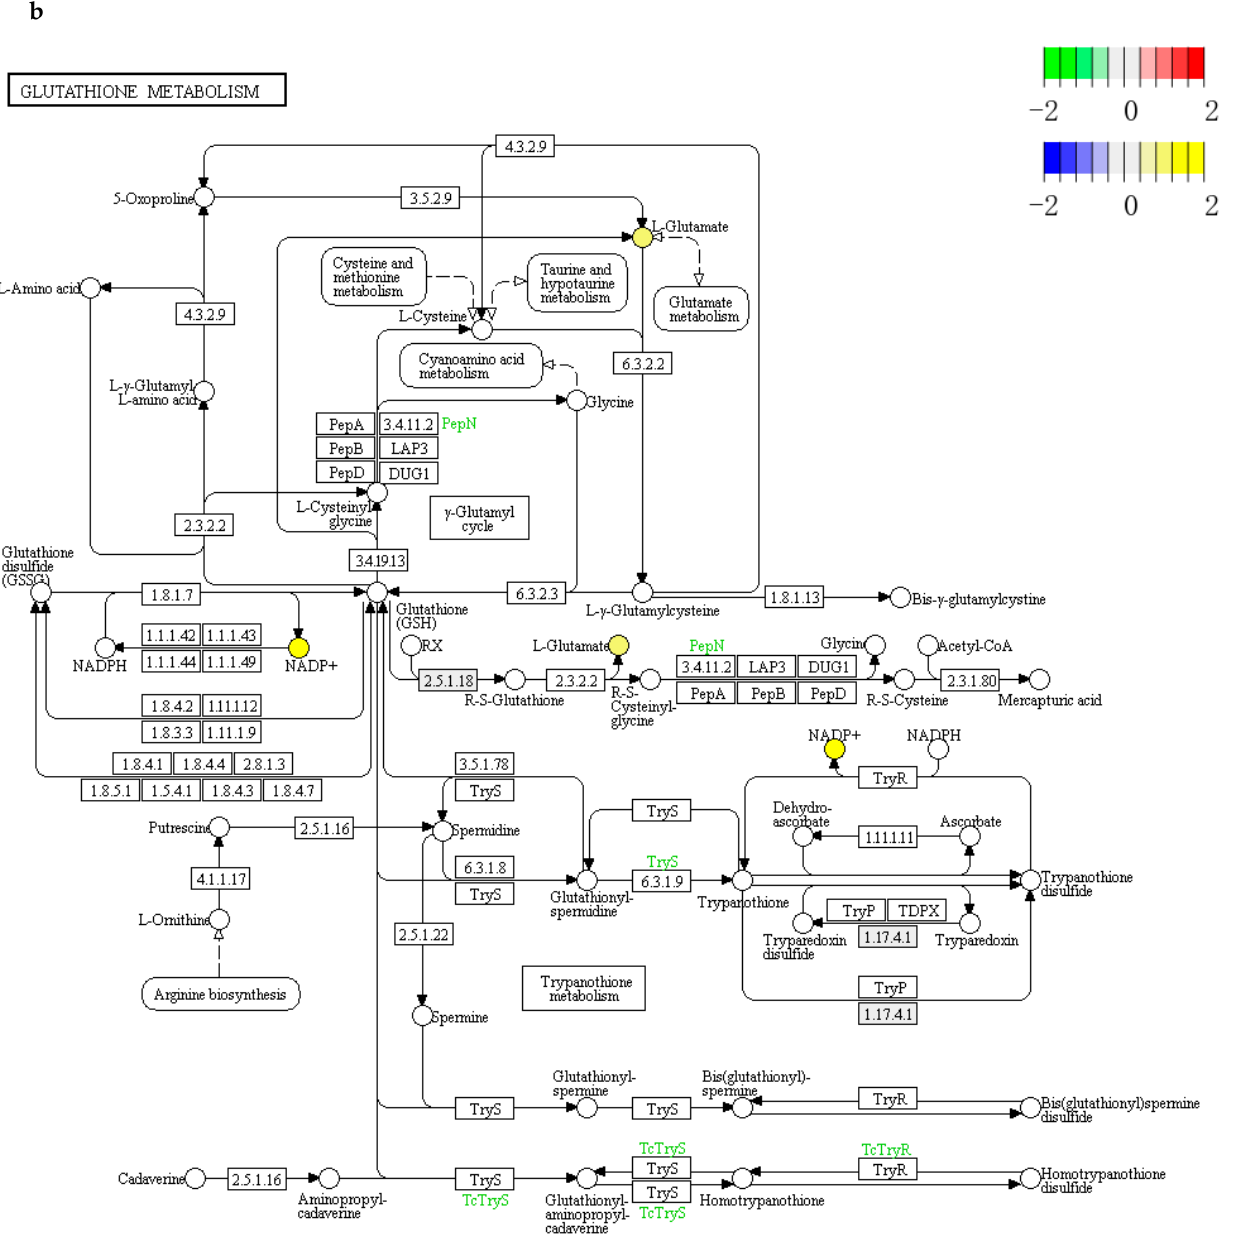
Figure 6. Combined metabolome and transcriptome analysis. ( a ) PathView enrichment pathway diagram (positive ion mode). According to the enrichment results, the metabolic pathways enriched in both metabolomics and transcriptomics are shown as pathway maps. In the KEGG pathway diagram, circles represent metabolites; blue circles represent downregulated differential metabolites, and yellow circles represent upregulated differential metabolites. The boxes represent genes or proteins, where the green boxes represent genes whose expression levels are differentially downregulated and the red boxes represent genes whose expression levels are differentially upregulated. ( b ) PathView enrichment pathway diagram (negative ion mode).